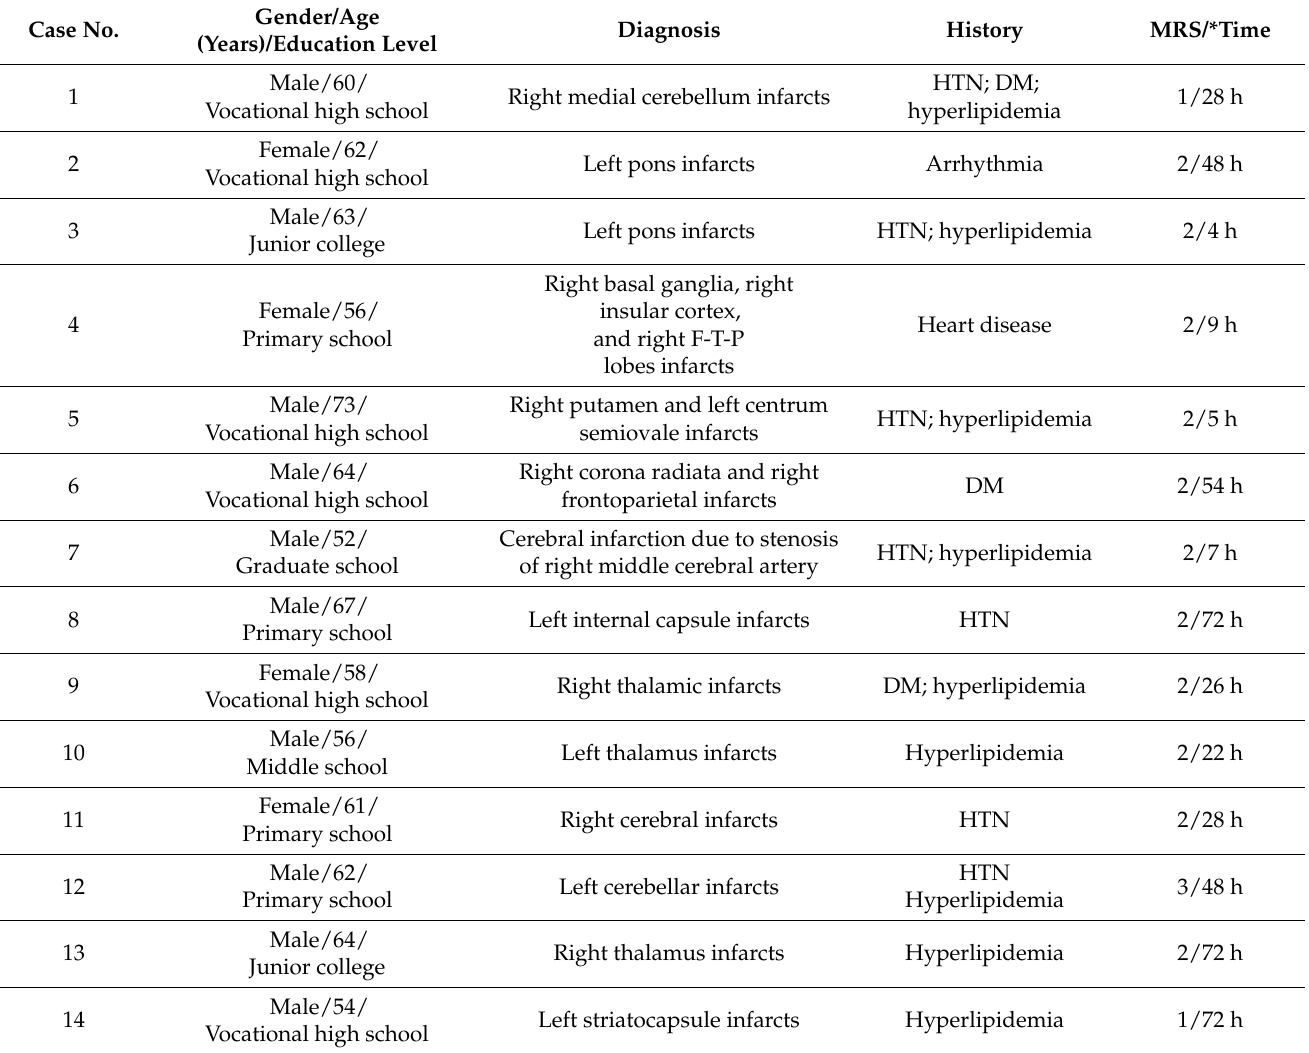
Figure 1. The theoretical framework. Table 1. Characteristics of the participants.